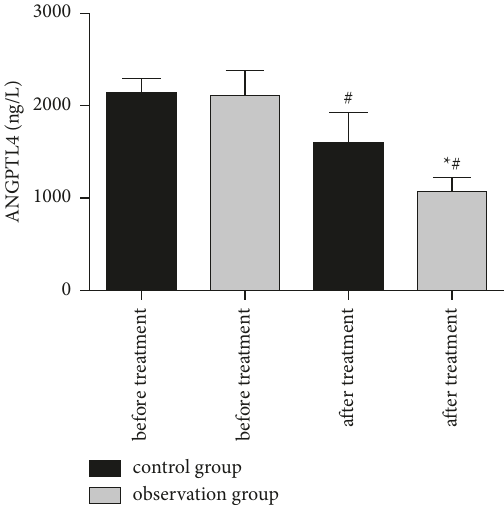
Figure 5: VEGF levels of two groups of patients at different times. Compared with the same group before treatment, # P < 0 . 05; compared with the control group, ∗ P < 0 .